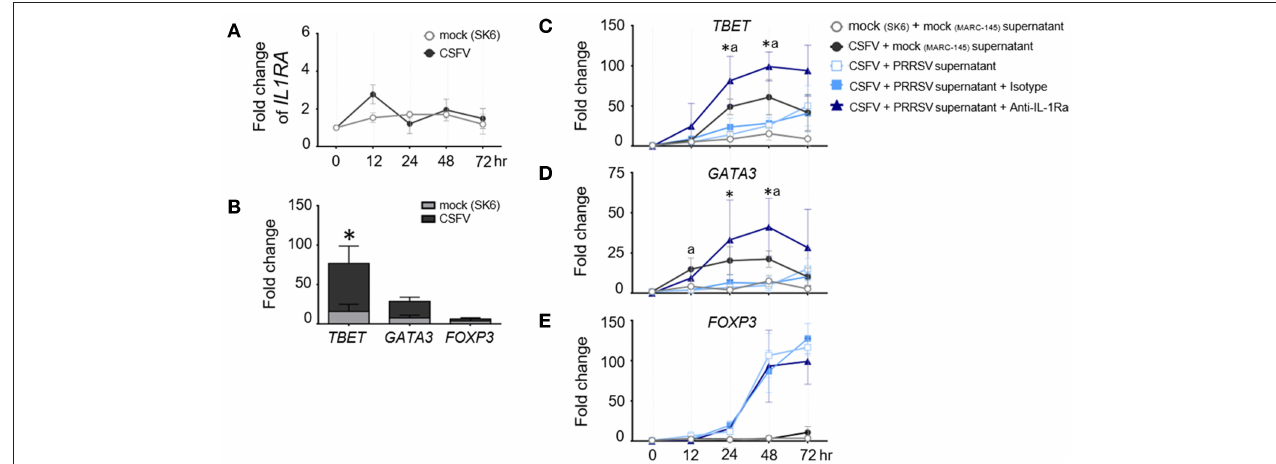
FIGURE 3 | PRRSV-induced IL-1Ra altered the expression of helper T lymphocyte transcriptional factors during the recalled antigen test. (A) CSFV had no effect on IL1RA gene expression. (B) Upon activation with the recalled antigen, CSFV, strong upregulation of TBET was observed in the CSFV-primed PBMC. *indicates significant difference levels at p < 0.05. (C–E) The levels of transcriptional factor gene expression in the CSFV-primed PBMC, upon reactivation with the recalled antigen. PRRSV-induced IL-1Ra decreased expressions of (C) TBET and (D) GATA3 , (E) but not FOXP3 gene expressions. The supernatants from type 2 PRRSV- or mock (MARC-145 cell lysate)-infected MoDC were pretreated with anti-IL-1Ra Ab for 2h prior to addition into the culture system. PBMC obtained from CSFV-immunized pigs were in vitro reactivated with CSFV or mock (SK6 cell lysate), in the presence of pretreated supernatants. Data represents mean ± SD from 5 pigs. Statistical significances were analyzed using t test (A) ANOVA followed by Tukey’s test (B–E) . a indicates significant difference between mock-infected cell supernatant (black circle) and PRRSV-infected cell supernatants (close and open light blue squares) at p < 0.05. * indicates significant difference between addition of anti-IL-1Ra Ab (dark blue triangle) and PRRSV-infected cell supernatants (close and open light blue squares) at p < 0.05.